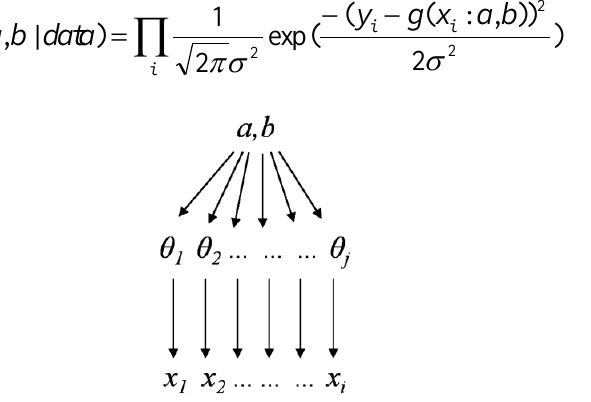
Figure 2. Bayesian non-hierarchical